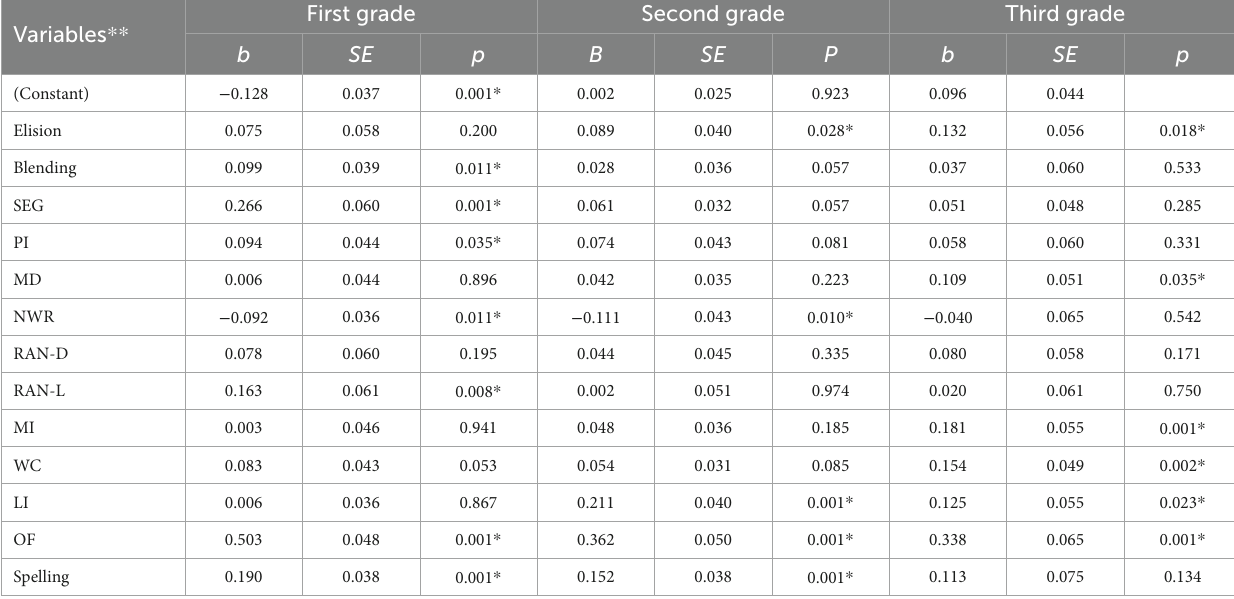
TABLE 6 Multiple regression results for individual subtest predictors of word reading accuracy.